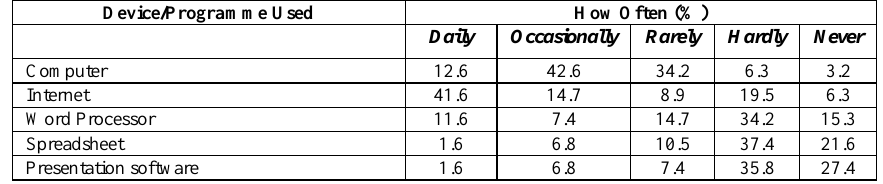
Table 9. Head Teacher Responses on ICT Device/Programme Use in the Past One Month Device/Programme Used